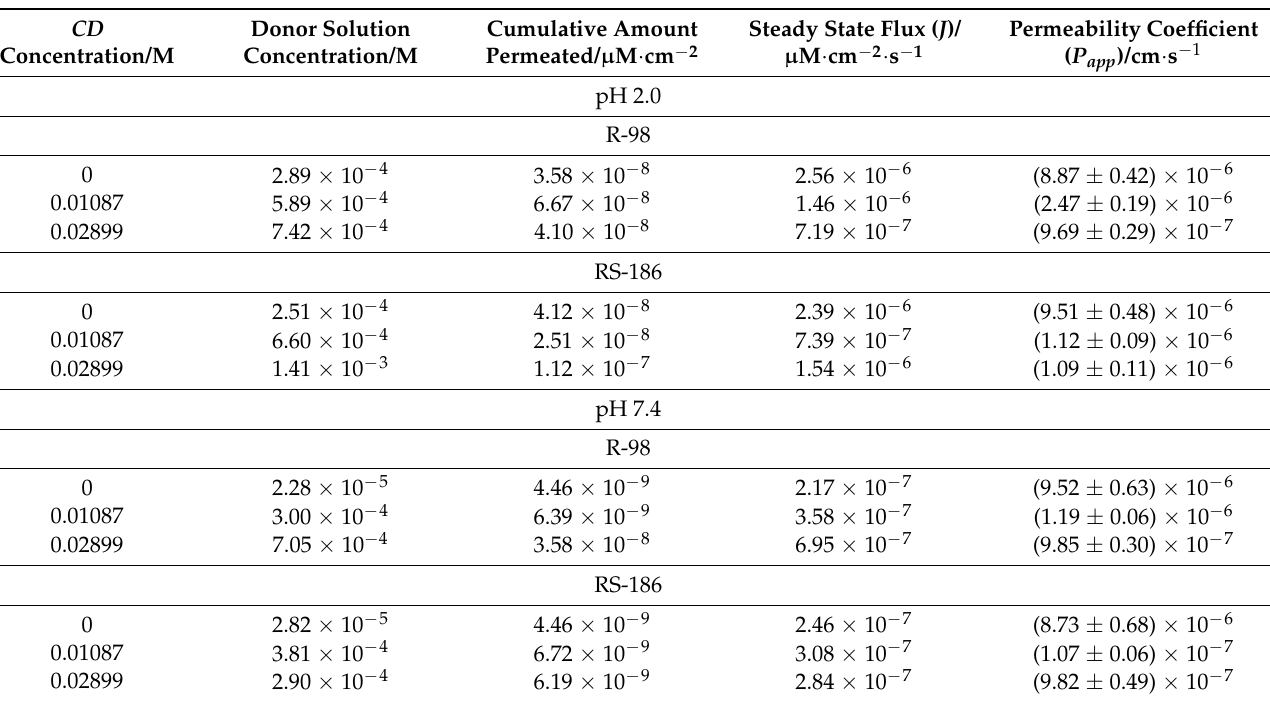
Table 4. Donor solution concentrations, cumulative amounts per unit area permeated in 5 h, steady state fluxes ( J ), and permeability coefficients ( P app ) of R-98 and RS-186 in the presence of CD in buffer solutions (pH 2.0 and pH